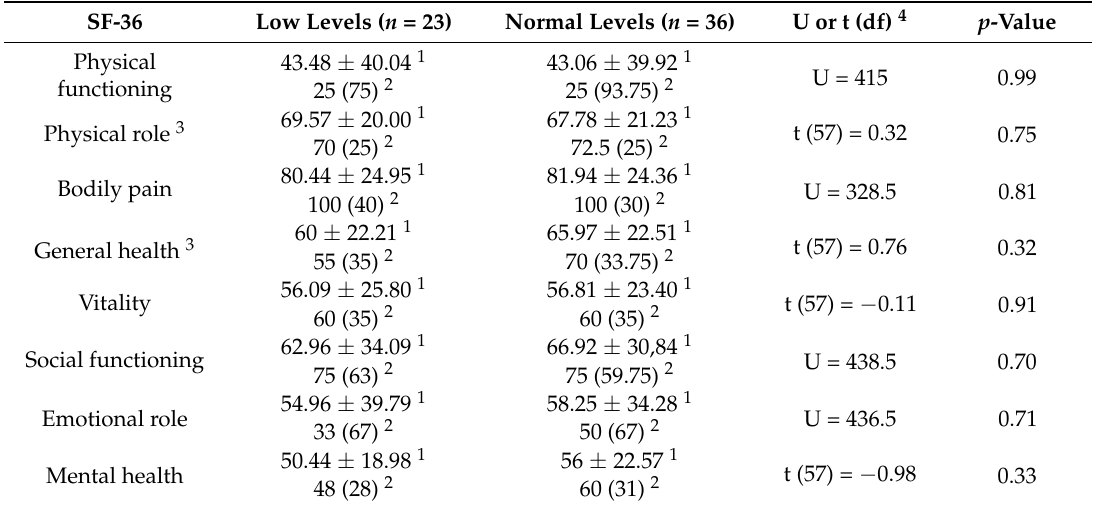
Table 12. Effects of white cell count levels on SF-36